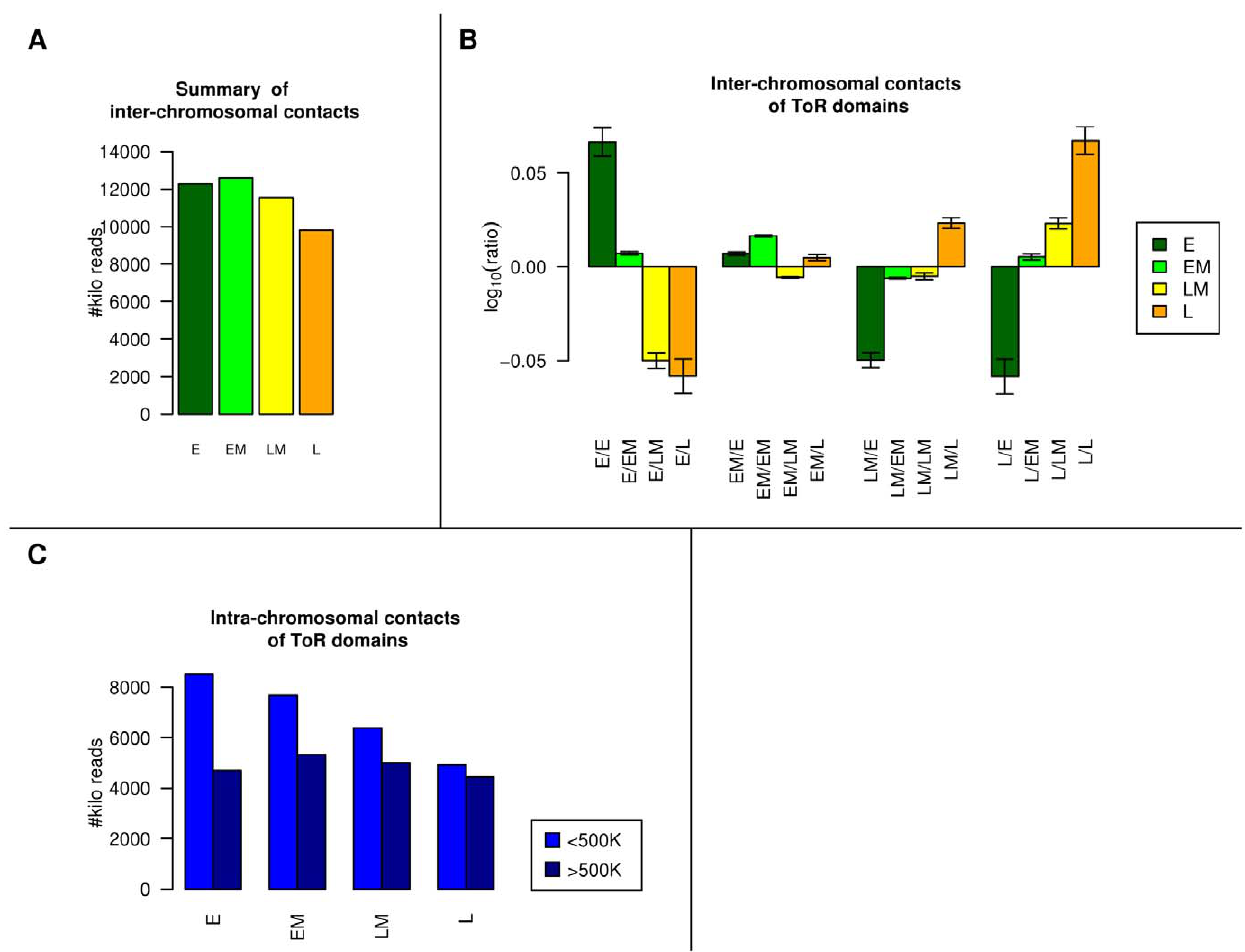
Figure 3. ToR and chromosomal interactions. (A) Late replicating domains are less accessible. The number of inter chromosomal interactions involving each replication time group are shown. We show the for each replication group the number of trans interactions that include this group (we call this measure the accessibility of the group). The late replicating group takes part in less interactions. (B) Regions with similar ToR tend to trans-interact. We show for each pair of replication groups the interaction ratio (log scale), which is the number of trans interactions, normalized according to the accessibility of the group (shown in Figure 3A). There is a bias towards self interactions within the early and the late replicating groups. (C) Early replicating DNA is more involved in close cis interaction. We show for each ToR group the number of intra-chromosomal interactions, divided into close interactions ( , 500K) and far interactions ( . 500K).